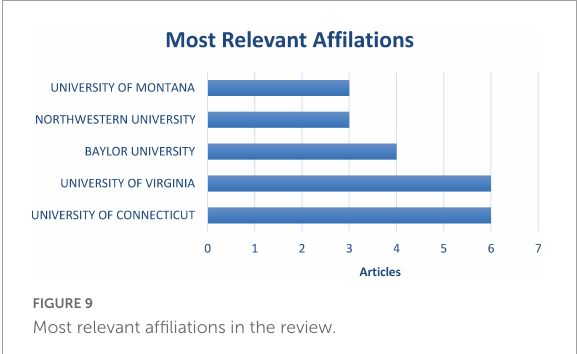
FIGURE9 Most relevant affiliations in the